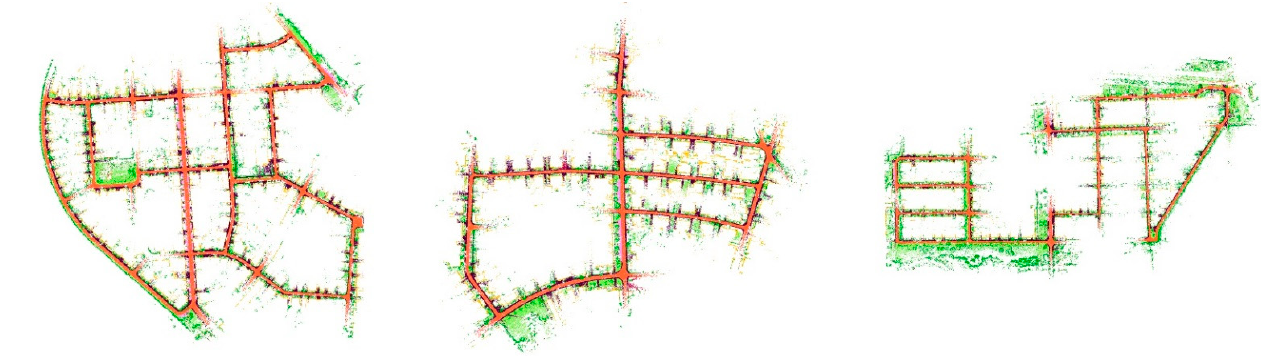
Figure 10. Experimental results of KITTI dataset.